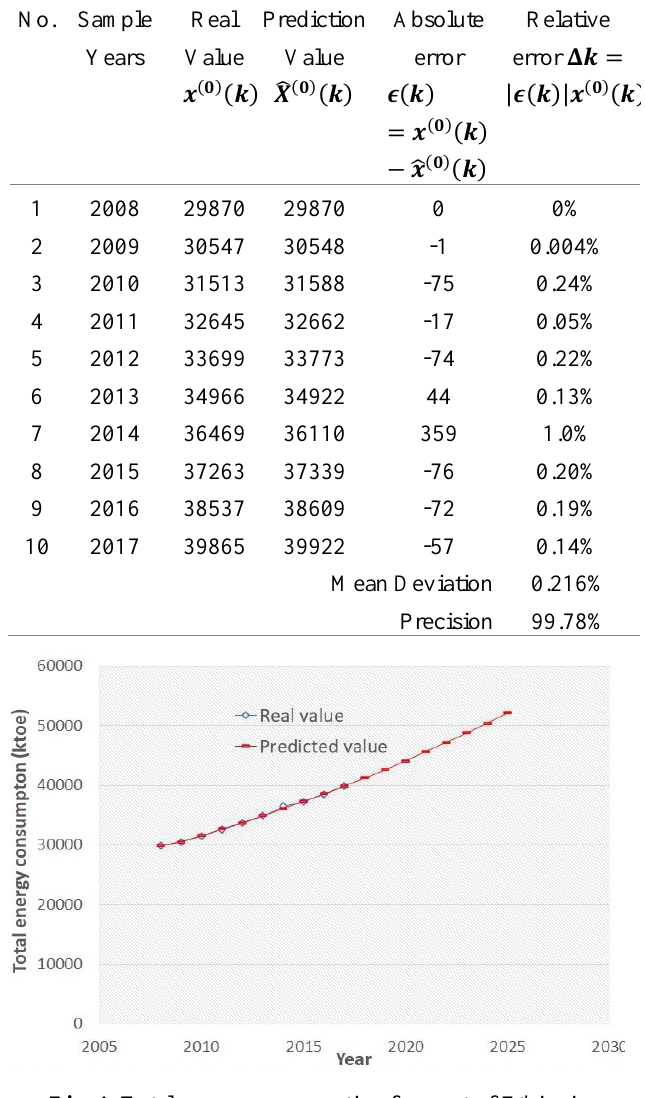
Fig. 4. Total energy consumption forecast of Ethiopia developed with Grey Model (1,1)